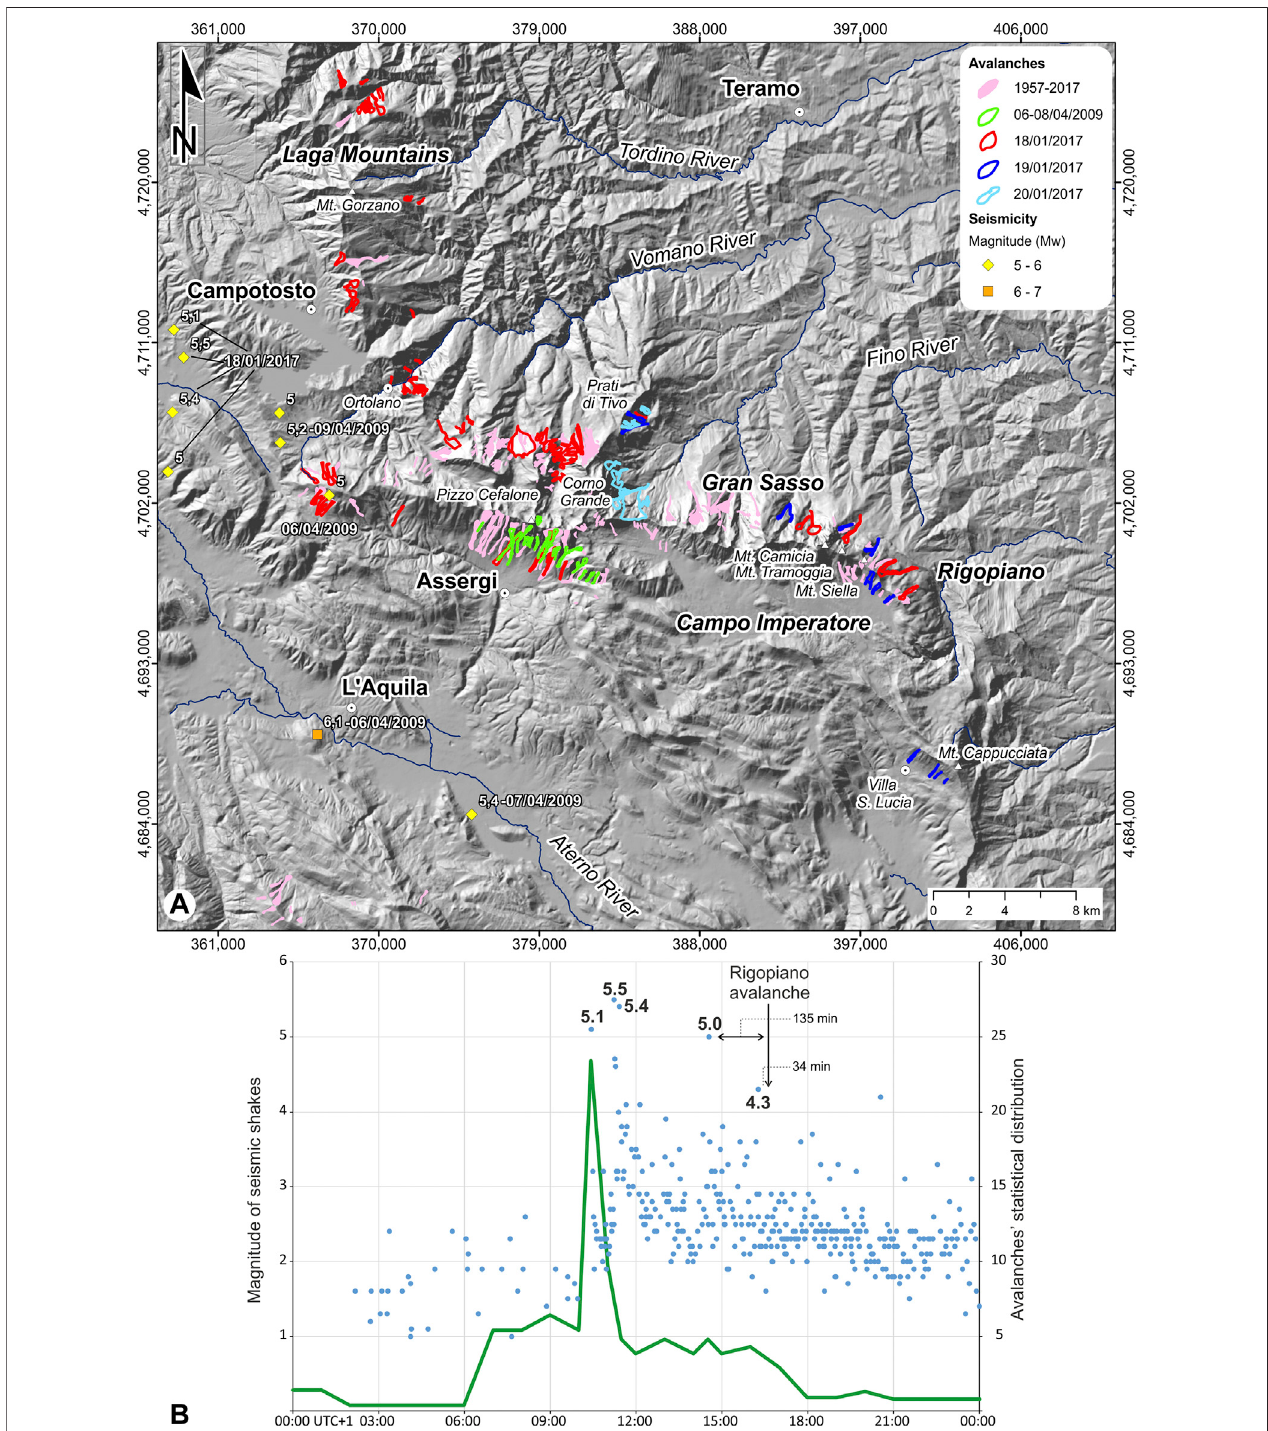
FIGURE 6 | (A) Avalanche distribution from 1957 to 2017. The avalanches recorded on 18 – 20 January 2017 are highlighted ( Supplementary Appendix C ; RegioneAbruzzo,2014)).Theseismicity(Mw > 5)inwinter(i.e.,December – April)ishighlightedandisonlyrecordedon6 – 9April2009andonJanuary18,2017( Table2 ; Supplementary Appendix A ). (B) Comparison of avalanches ’ temporal distribution (green line derived from the processing of Supplementary Appendix C (Regione Abruzzo, 2014)) and seismic shocks time distribution on January 18, 2017 (blue dots, from CPTI18 in Rovida et al. (2019)).